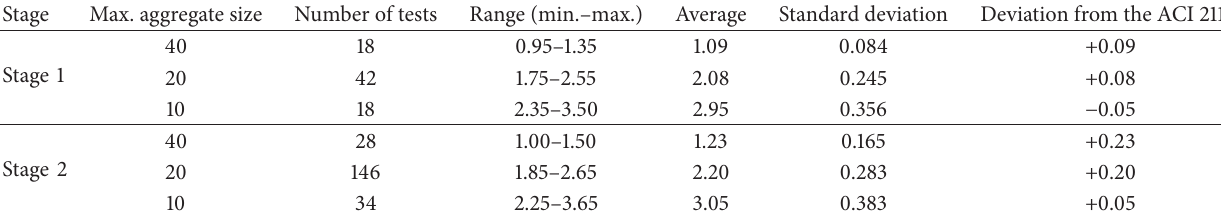
Table 3: Entrapped air in concrete